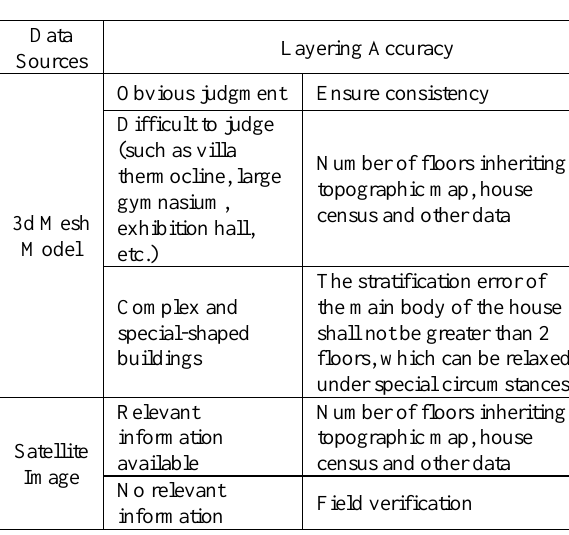
Table 4 . Quality requirements for layering